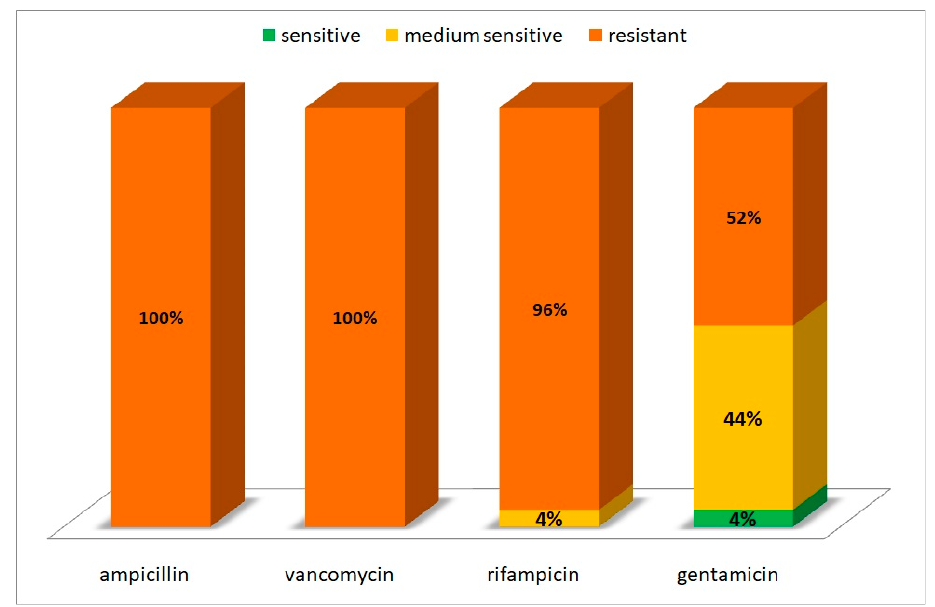
Figure 4. Antibiotic resistance of bacteria isolated from the samples of Oligocene waters.